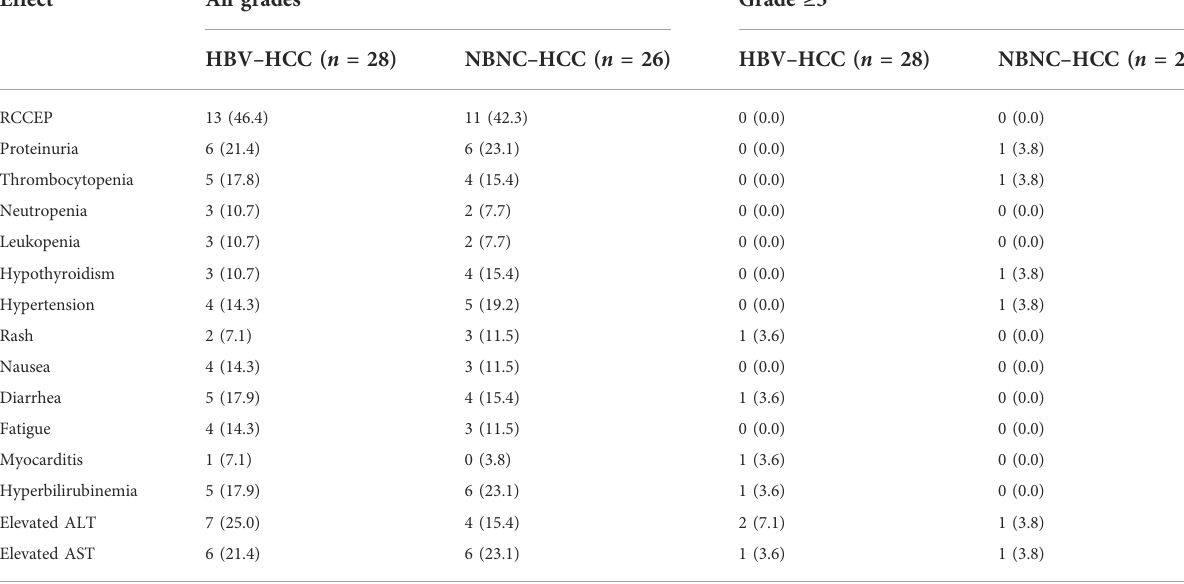
TABLE 4 Treatment-related adverse events in patients with hepatocellular